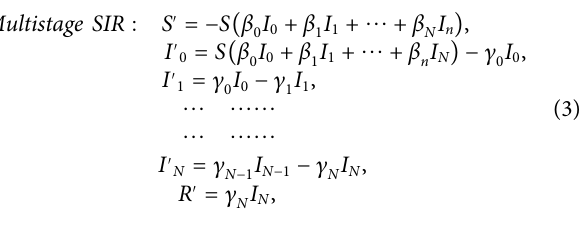
Frontiers in Physics |